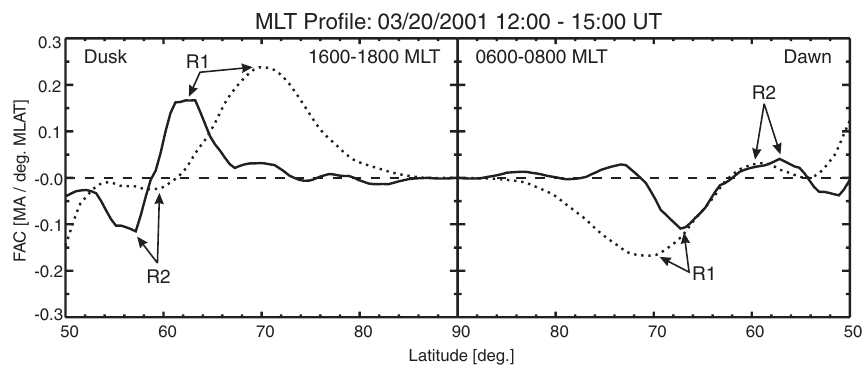
Fig. 6. Differential total field-aligned currents from Iridium (solid line) and LFM simulation (dotted line) at dawn and dusk for 20 March 2001,